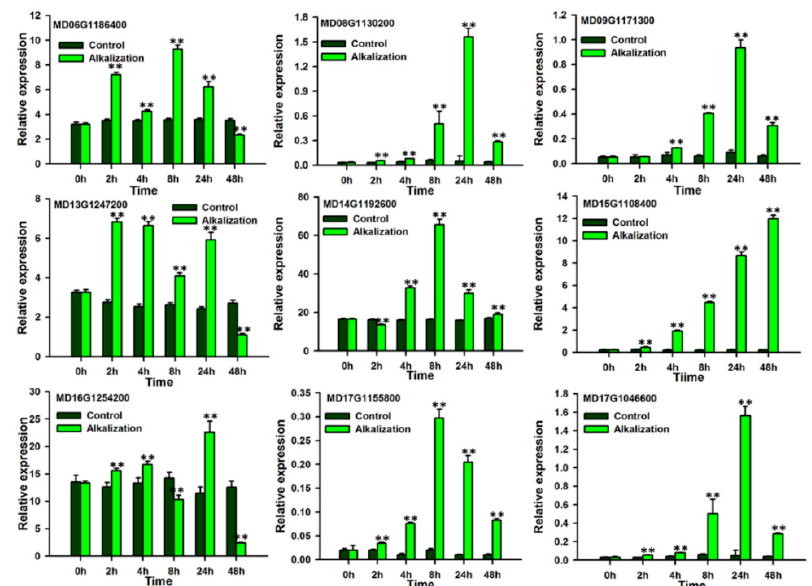
Figure 6. Expression profiling of the apple P 3A -Type ATPase genes in roots of Malus prunifolia (Willd.) Borkh. under control and alkaline condition at different treatment times. The values indicate the average of three biological replicates. Error bars indicate the SD of the mean, and the double asterisks show significant differences between control and treatments ( t -test, p < 0.01).